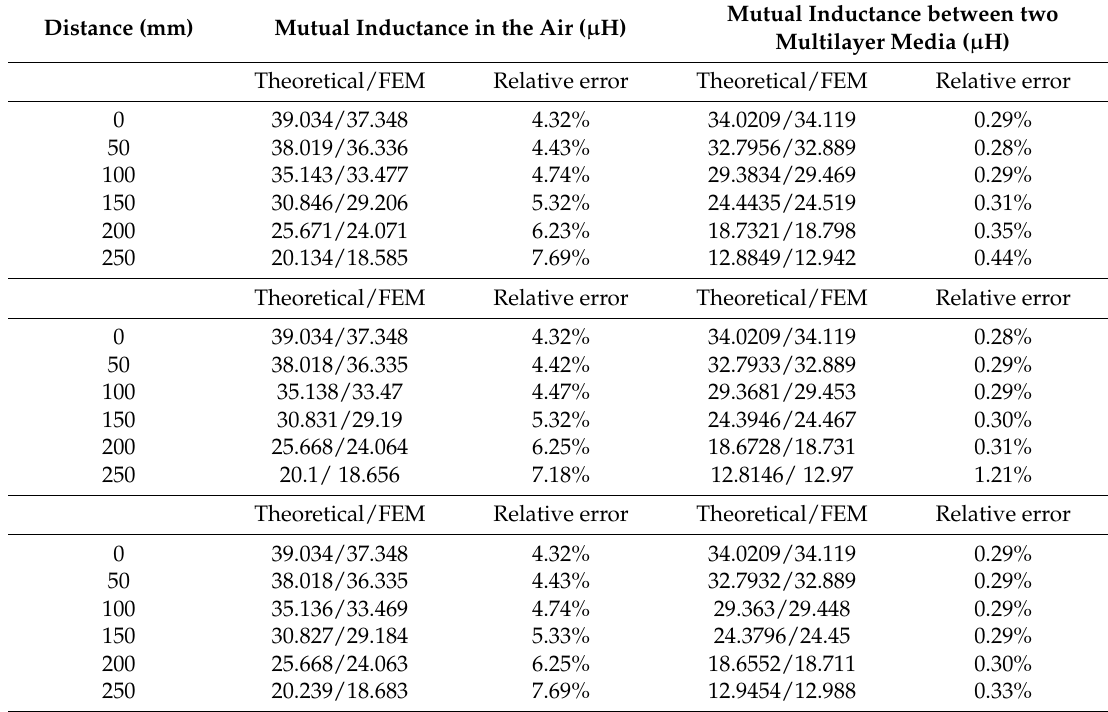
Table 2. Results of the non-cylindrical feature investigation. FEM: finite element model.